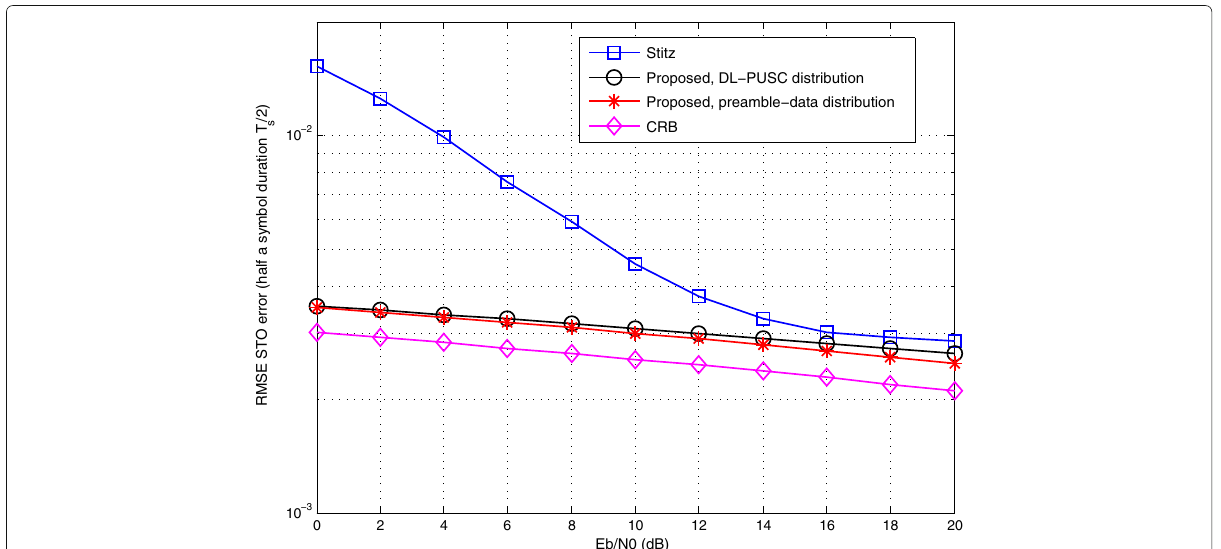
Fig. 5 Comparative RMSE error of STO estimation versus input E b / N 0 with CFO = 5% and Rayleigh channel